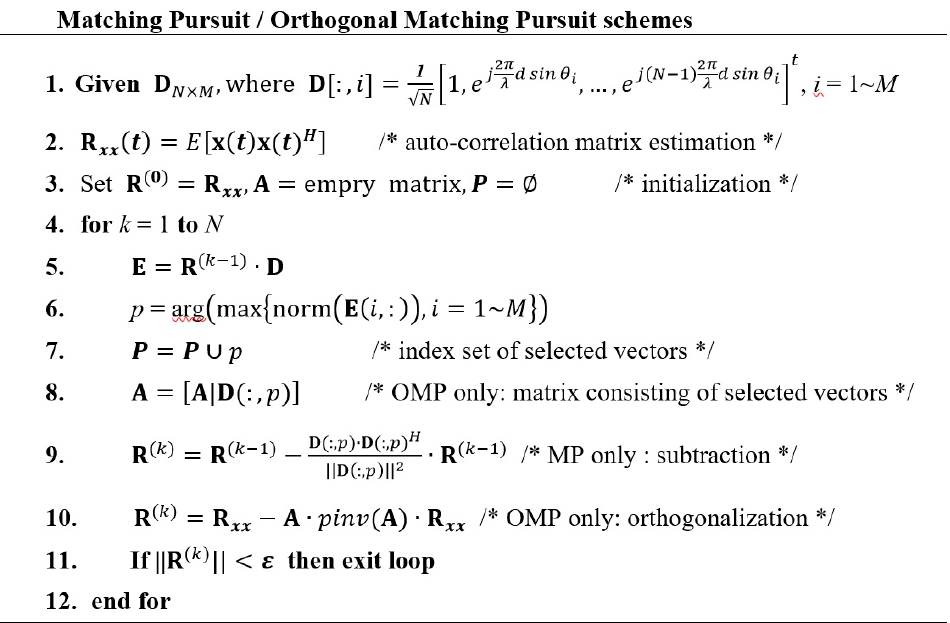
Figure 2. Combined pseudo code of the Matching Pursuit/Orthogonal Matching Pursuit (MP/OMP) DoA estimation algorithms.